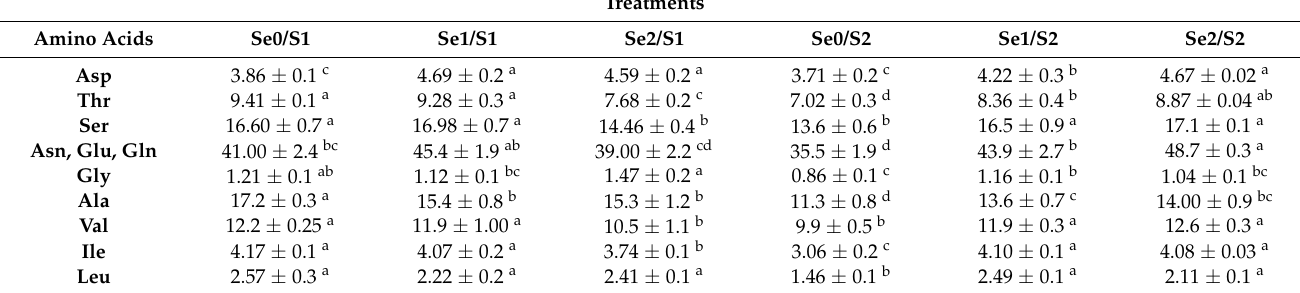
Table 2. Amino acids accumulation in lettuce plants grown in a hydroponic system and treated with two S levels (S1: 1 mM; and S2: 2 mM (K 2 SO 4 )), and three Se levels (Se0: 0 µ M; Se1: 1.3 µ M; and